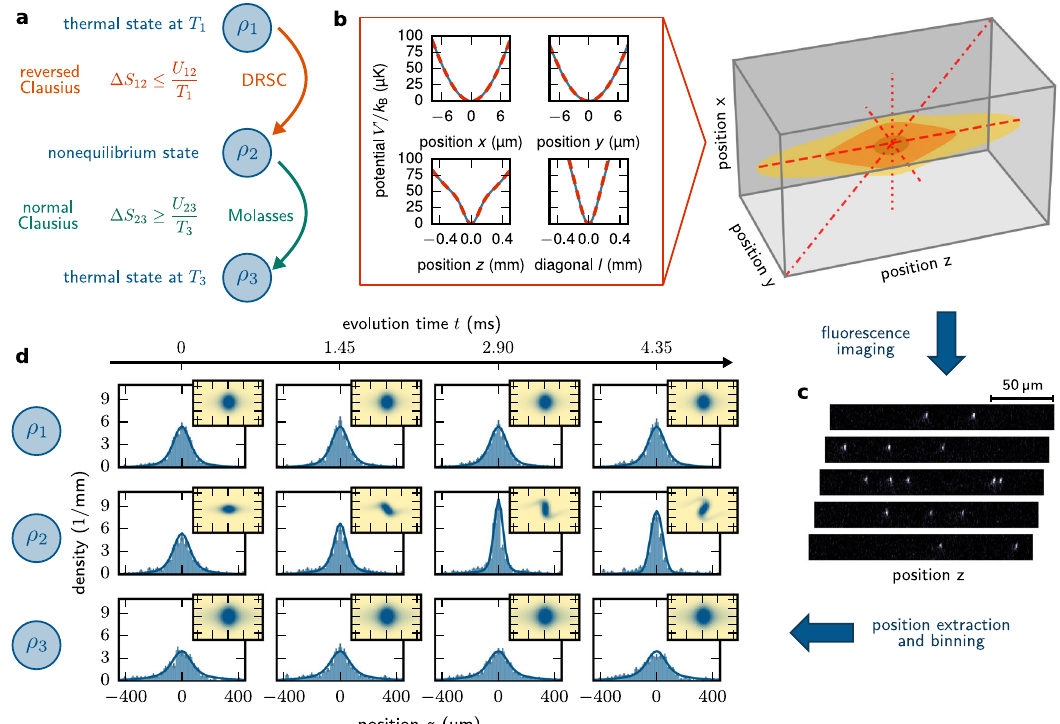
Fig. 1 Experimental setup. a Schematic of the two thermodynamic processes examined: (i) transition from the equilibrium state ρ 1 to the nonequilibrium state ρ 2 induced by a degenerate Raman sideband cooling (DRSC) pulse and (ii) transformation from the nonequilibrium state ρ 2 to the thermal state ρ 3 generated by an optical molasses pulse. b Characterization of the dipole trap potential V ( x , y , z ) used to store the Cesium (Cs) atoms. The red lines indicate the different directions of the potential cuts shown in the inset: the full potential (blue lines) is there compared to a separable potential approximation (red dashed lines) along the x -, y - and z -direction, as well as a diagonal cut indicated by its length l . c Typical fl uorescence images of the few Cs atom samples showing single Cs atoms as bright spots. By extracting the atomic positions along the z -axis from the images and binning them in a histogram, the atomic density distribution is measured. d For every state of the experimental protocol, the position distribution is measured at four evolution times, t = 0, 1.45, 2.90 and 4.35 ms (blue bars). By combining the measured dynamics with a model (solid lines), the full axial phase-space distribution can be determined